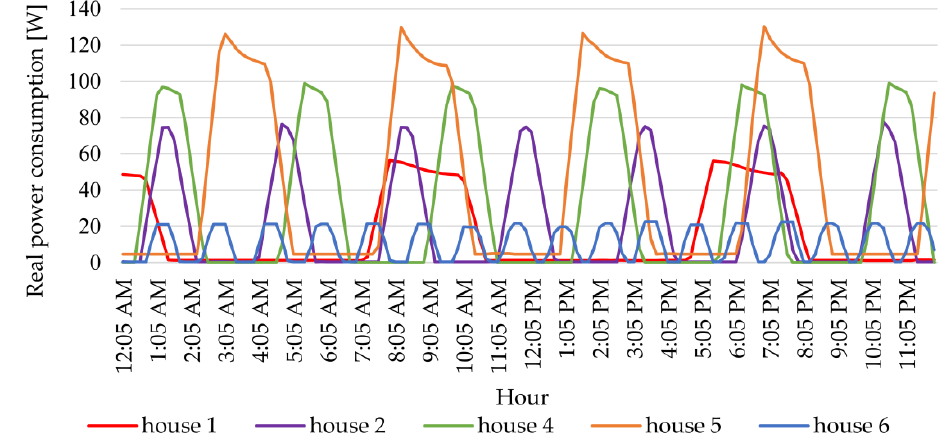
Figure 8. Electricity consumption generated by fridges.